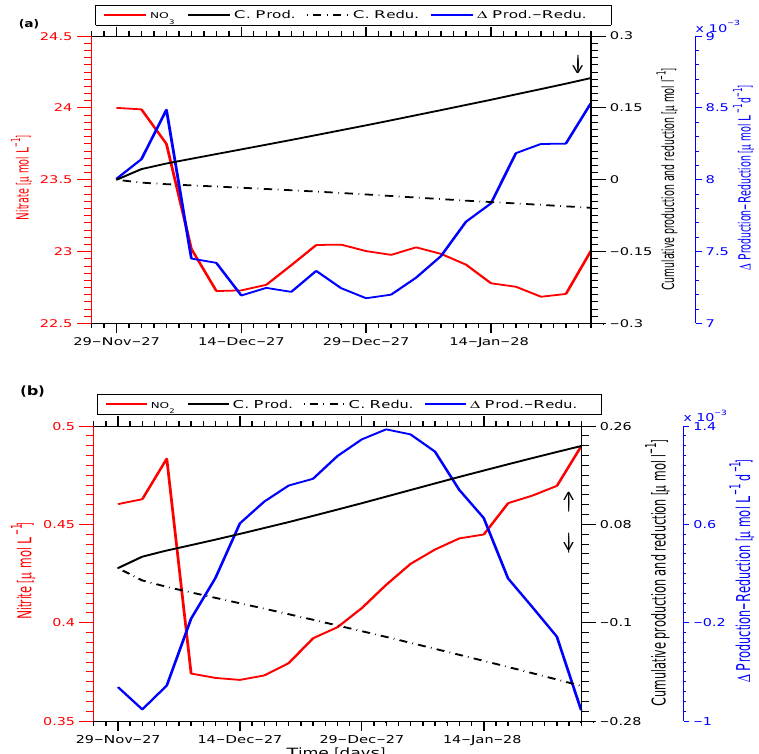
Figure 9. (a) Time evolution of cumulative production (full black line, (µmolL − 1 ), cumulative reduction (dashed black line, µmolL − 1 ), production-reduction difference (blue line, µmolL − 1 d − 1 ) and available nitrate (red line, µmolL − 1 ) within the subsurface layer of the eddy B sim . (b) The same as (a) but for nitrite. The concentration and fluxes in (a, b) correspond to averaged quantities between 100 and 200m depth layer within the eddy structure. Arrow indicates the time when the sections in Fig. 5 were